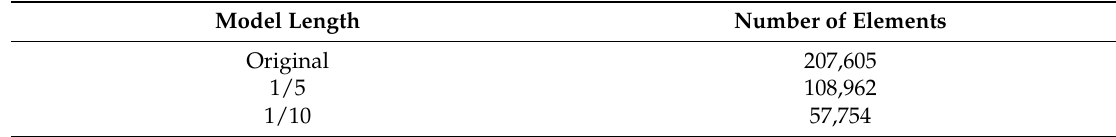
Table 1. Number of elements of different model length.